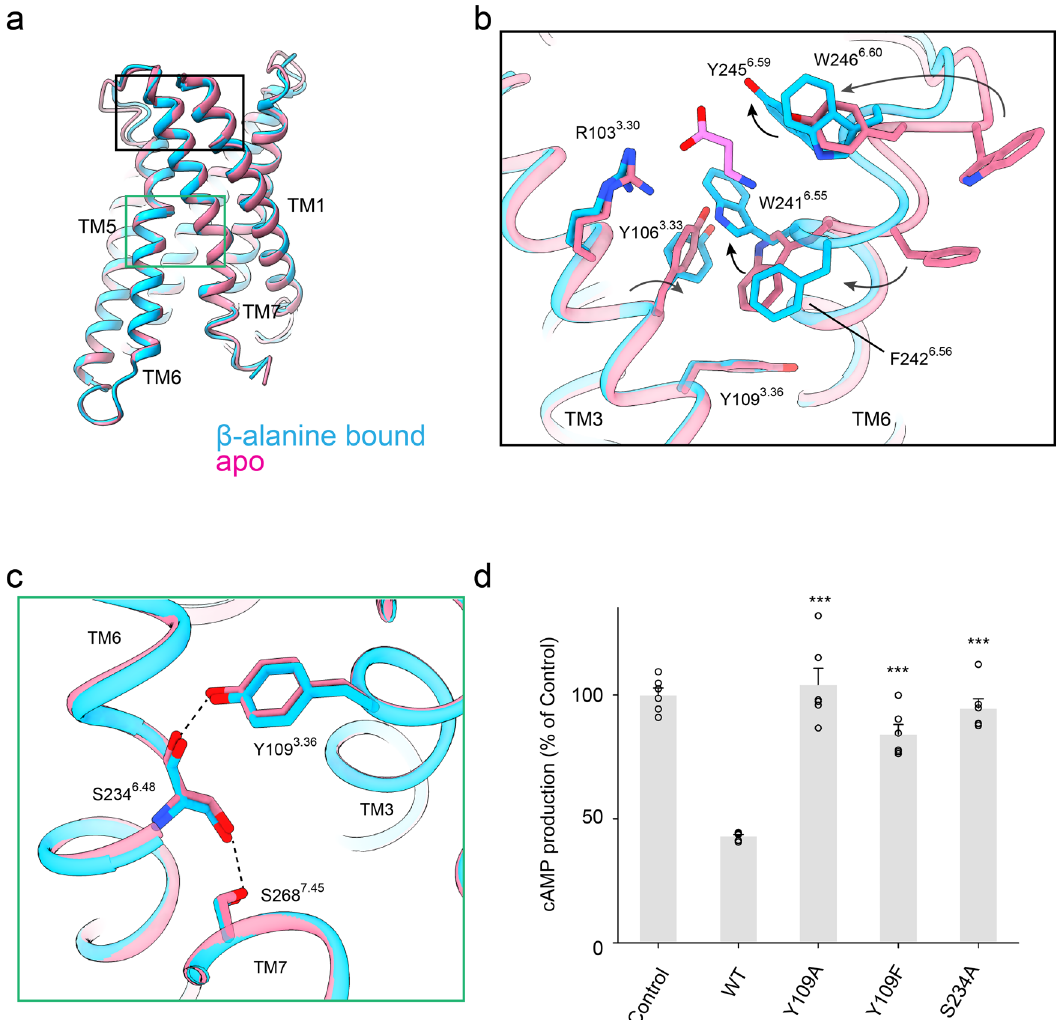
Fig. 6 Apo vs. β -alanine-bound MrgD. a Superposition of the apo state (pink) and β -alanine-bound state (cyan) of MrgD is represented in cartoon style. b Magni fi ed view of the ligand-binding pocket of the apo (red) and β -alanine-bound MrgD (cyan). The residues of interest are shown as sticks. The black arrows indicate the conformational transition from the apo to the β -alanine-bound state. c Critical residues for the basal activity of MrgD The side chains of Y109 3.36 , S234 6.48 , and S268 7.45 are shown as sticks. The black dotted line indicates the hydrogen bond. Colors are consistent with ( b ). d The basal activity of WT MrgD and mutants was measured by cAMP inhibition assay. *** p < 0.001 (one-way analysis of variance [ANOVA] followed by the Dunnett ’ s test, compared with the response of WT. Data represent mean ± s.e.m ( n = 6). The expression levels of these mutants at the cell surface